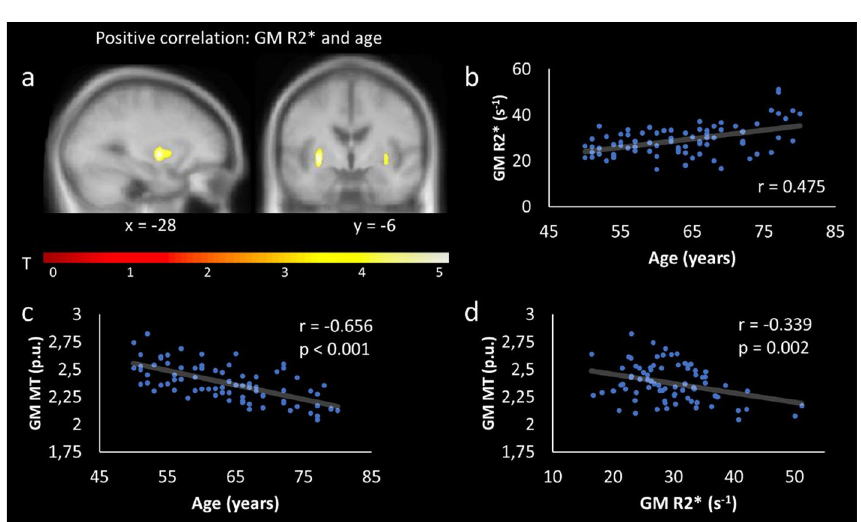
Figure 3. Positive relationship between age and GM R2*. ( a ) SPM showing a significant positive relationship between GM R2* and age within the left and right putamen; (b) shows the corresponding correlation plot for the cluster. For post hoc analyses, GM MT values were extracted from the same cluster. They revealed a negative relationship between GM MT and age ( c ), and a negative relationship (not corrected for age) between GM R2* and GM MT ( d ). For display purposes, SPM was thresholded at p < 0.001, uncorrected, and superimposed on the mean T1-weighted